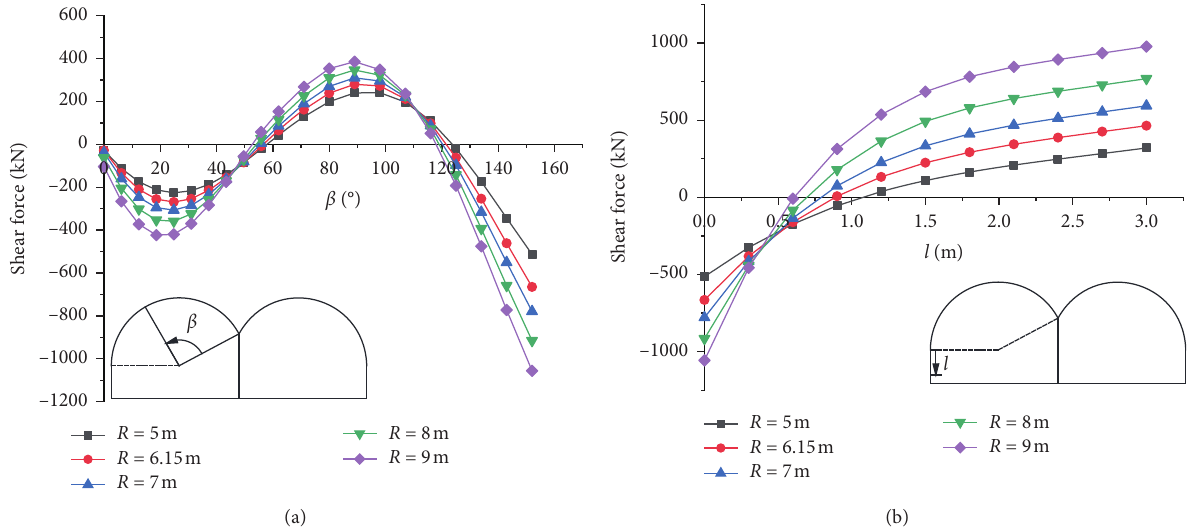
Figure 24: Variations of shear force with R: (a) along the arch ring; (b) along the side wall.